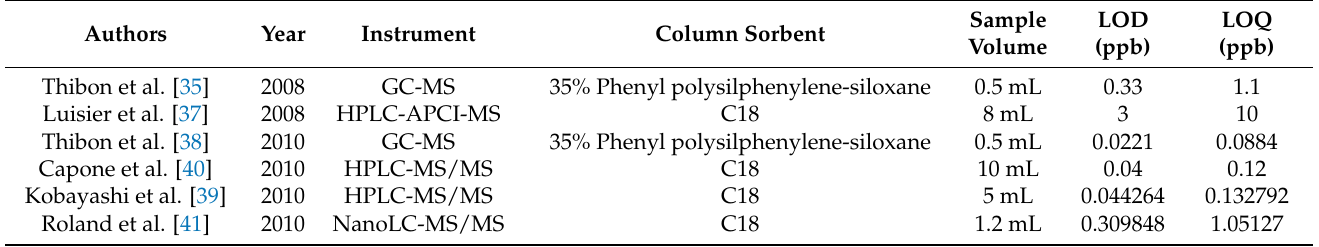
Table 1. A summary of early methods for the quantification of C3SH, comparing LOD and LOQ for methods using GC-MS and